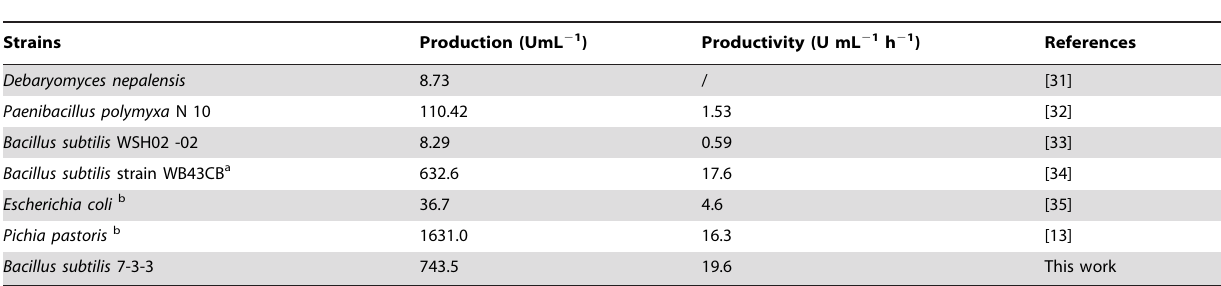
Table 1. PGL production of reported strains by optimized fermentation.